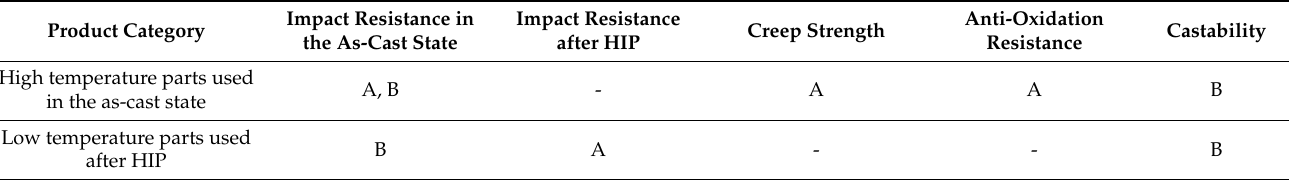
Table 1. Essential properties required for TiAl cast